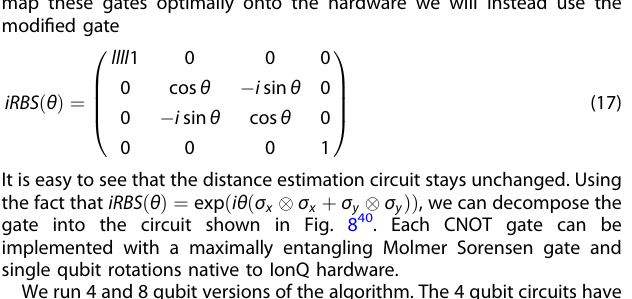
Fig. 9 The experimentally estimated value of c vs its value from simulation. This data correspond to the synthetic dataset with N q = 4, N d = 8, and N s =